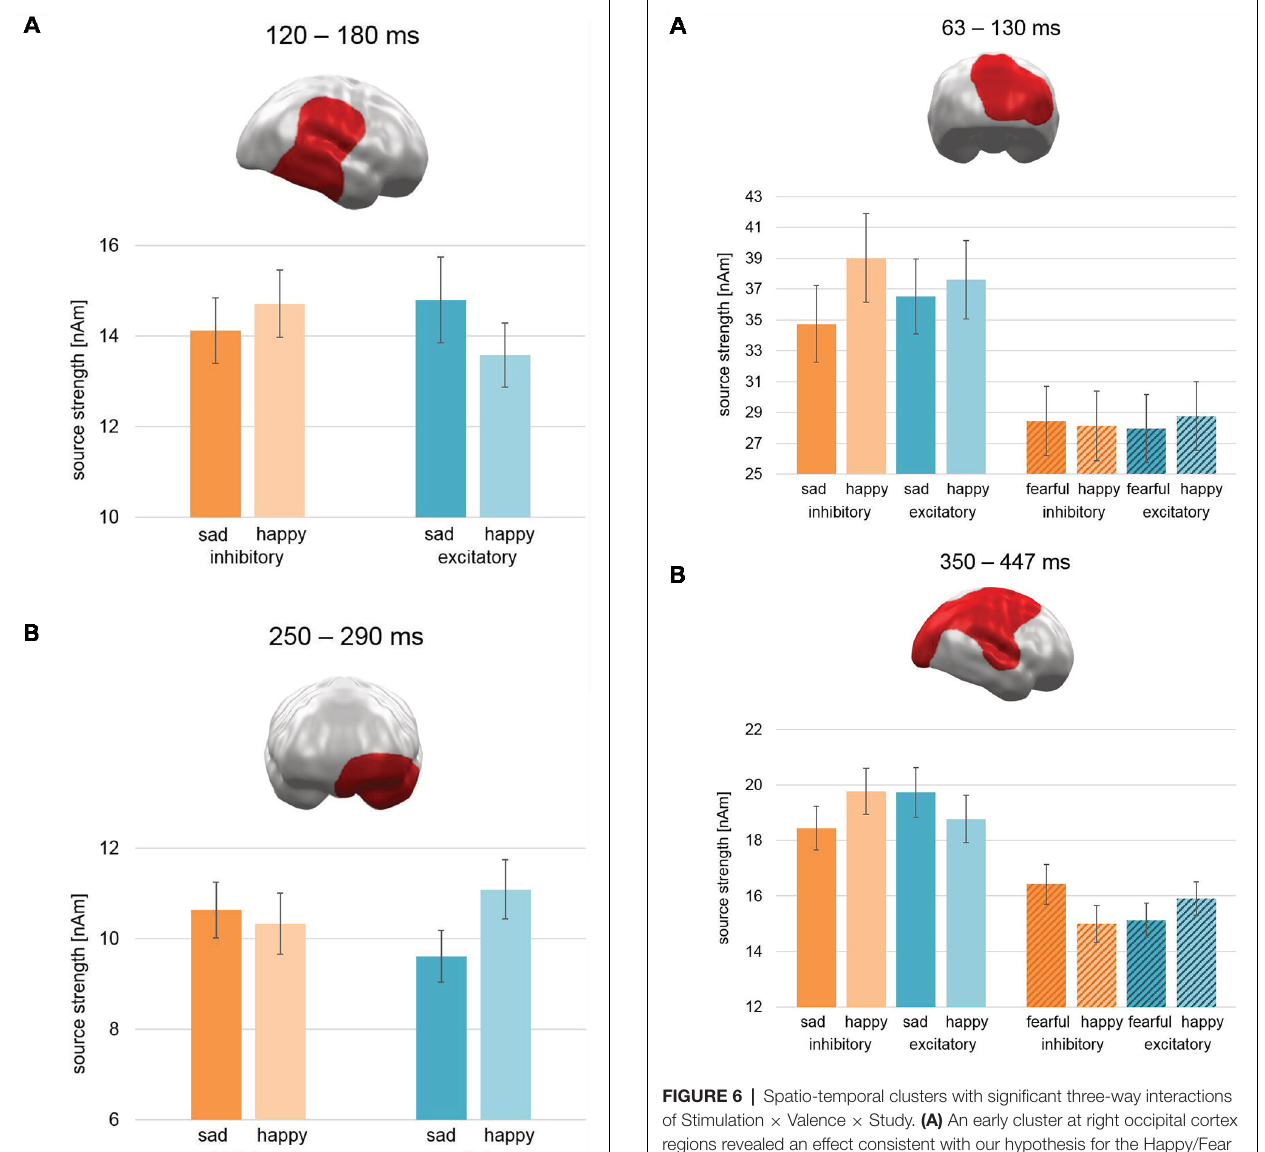
with our a priori hypothesis (Excitatory: Sad < Happy, Inhibitory: Happy > Sad) showing an overall higher activation for happy faces relative to sad faces, while the difference between happy and sad faces decreased from Inhibitory